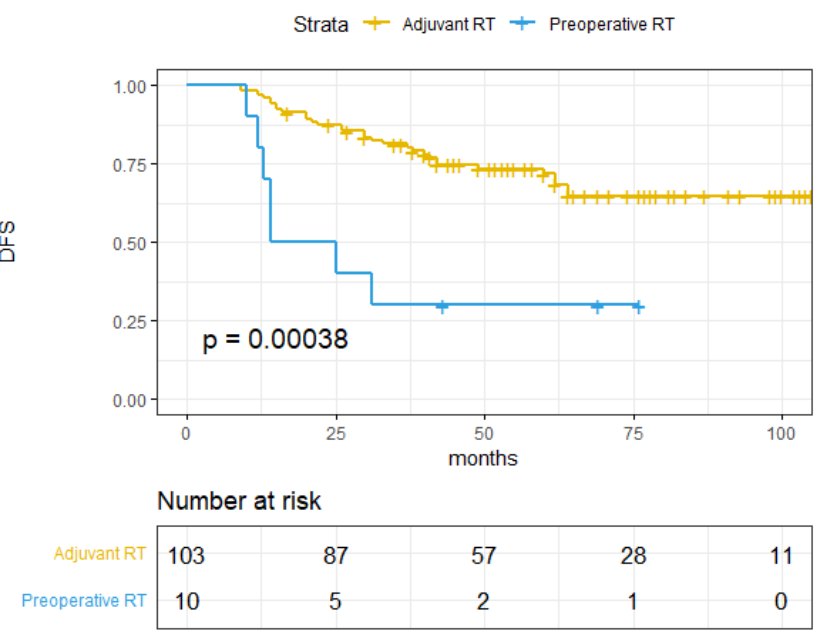
Figure A2. DFS with adjuvant radiotherapy (5-y DFS: 71.8% [63.1–81.6%]) vs. with preoperative radiotherapy (30.0% [11.6–77.3%]).